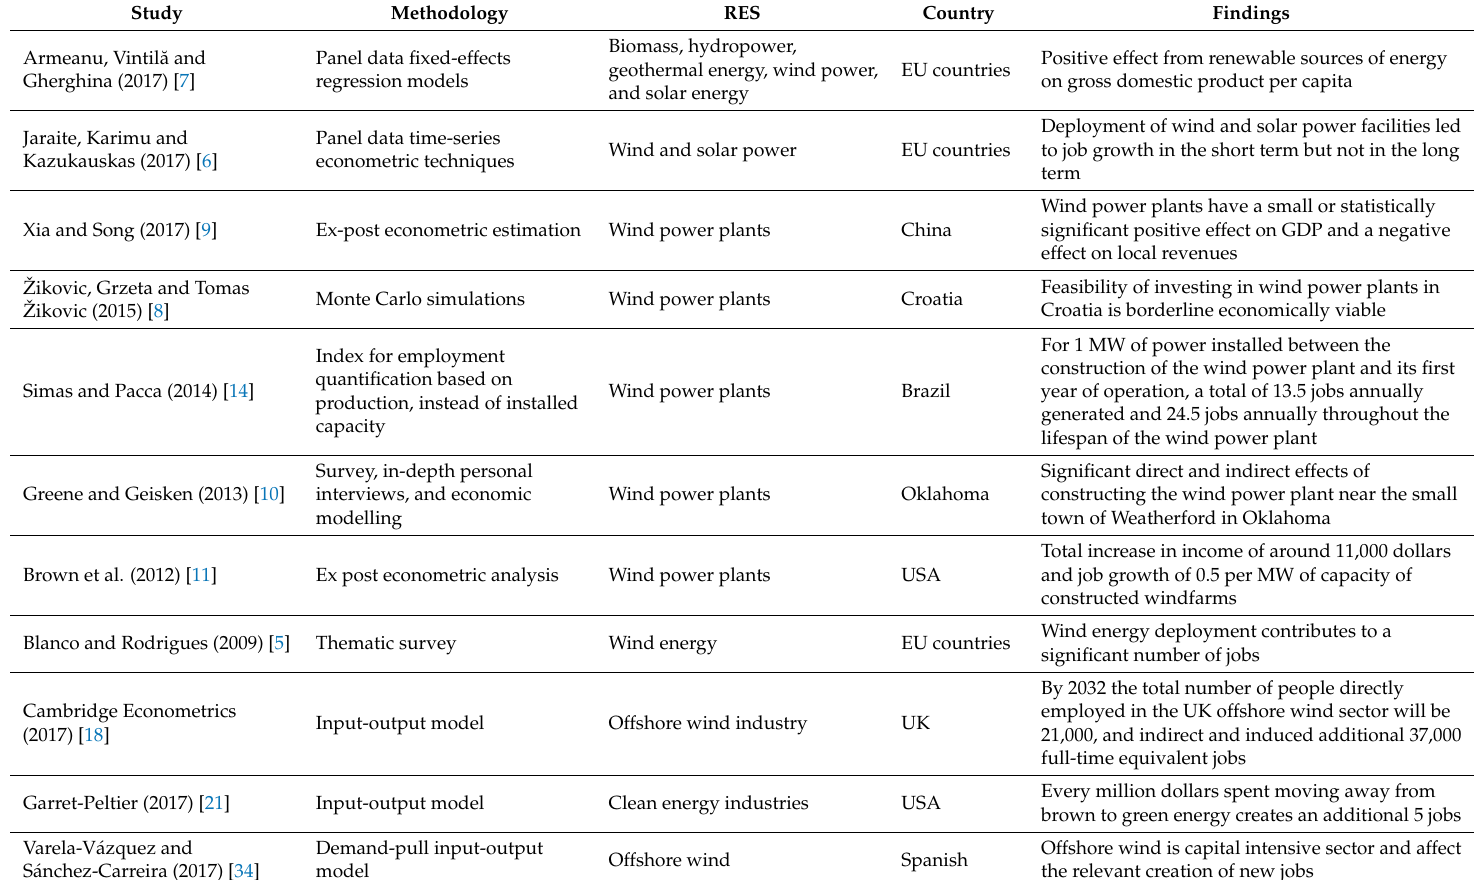
Table A1. Systematization of the papers dealing with the economic effects of wind power plants